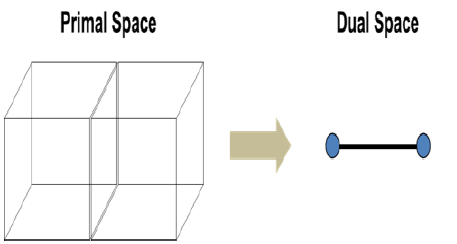
Figure 2. Basic concept of development for Indoor Spatial Data Model